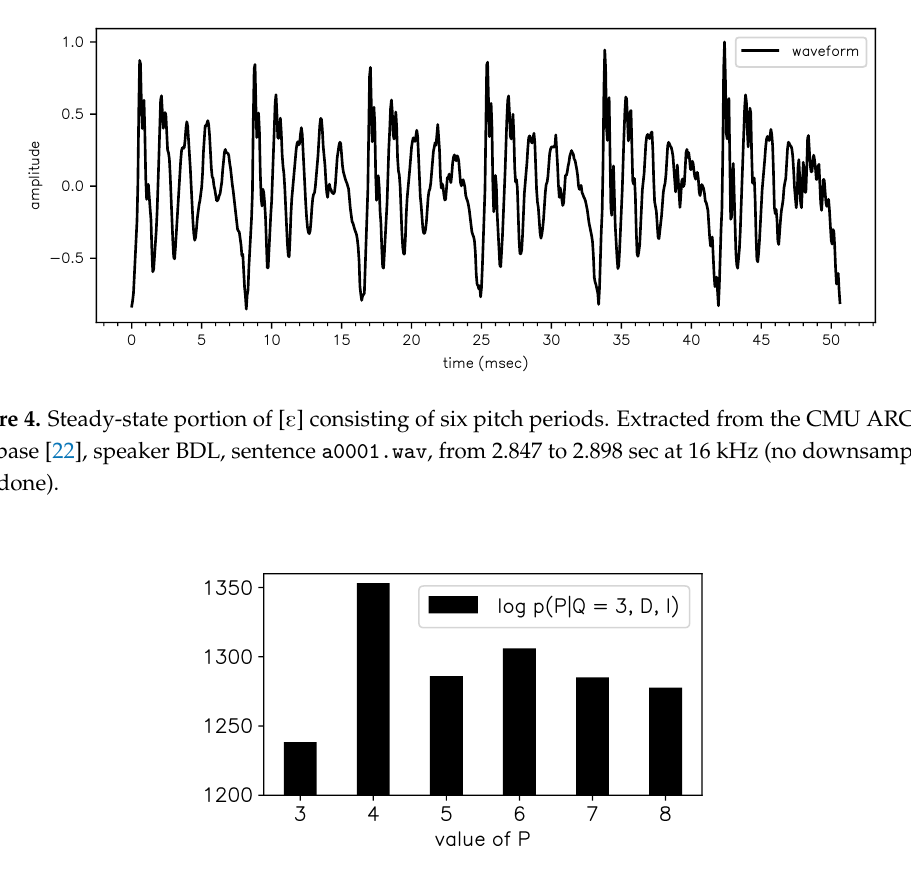
Figure 5. The posterior probability p ( P | Q = 3, D 1 · · · D 6 , I ) for the SSV / E